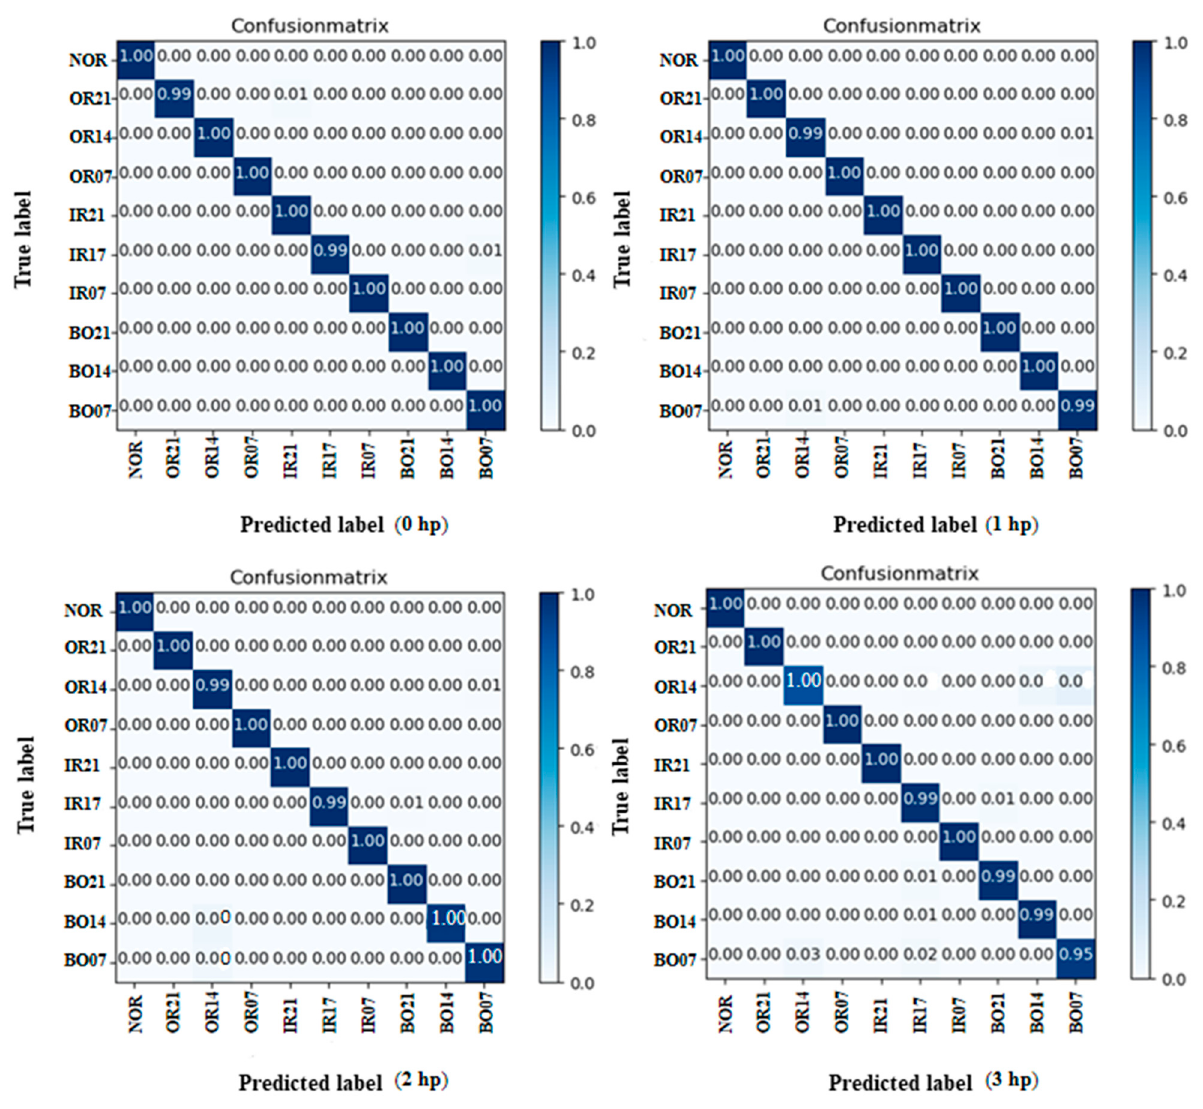
Figure 11. Training result.